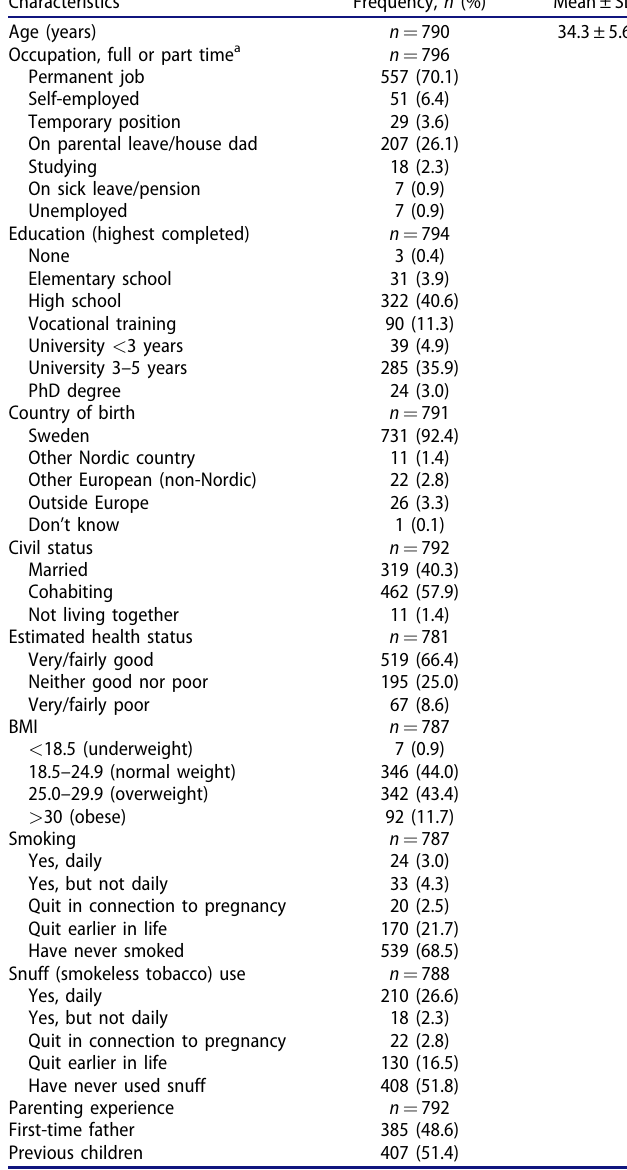
Table 3. Pregnancy-planning and preconception lifestyle adjustments in regard to the child born one year ago.